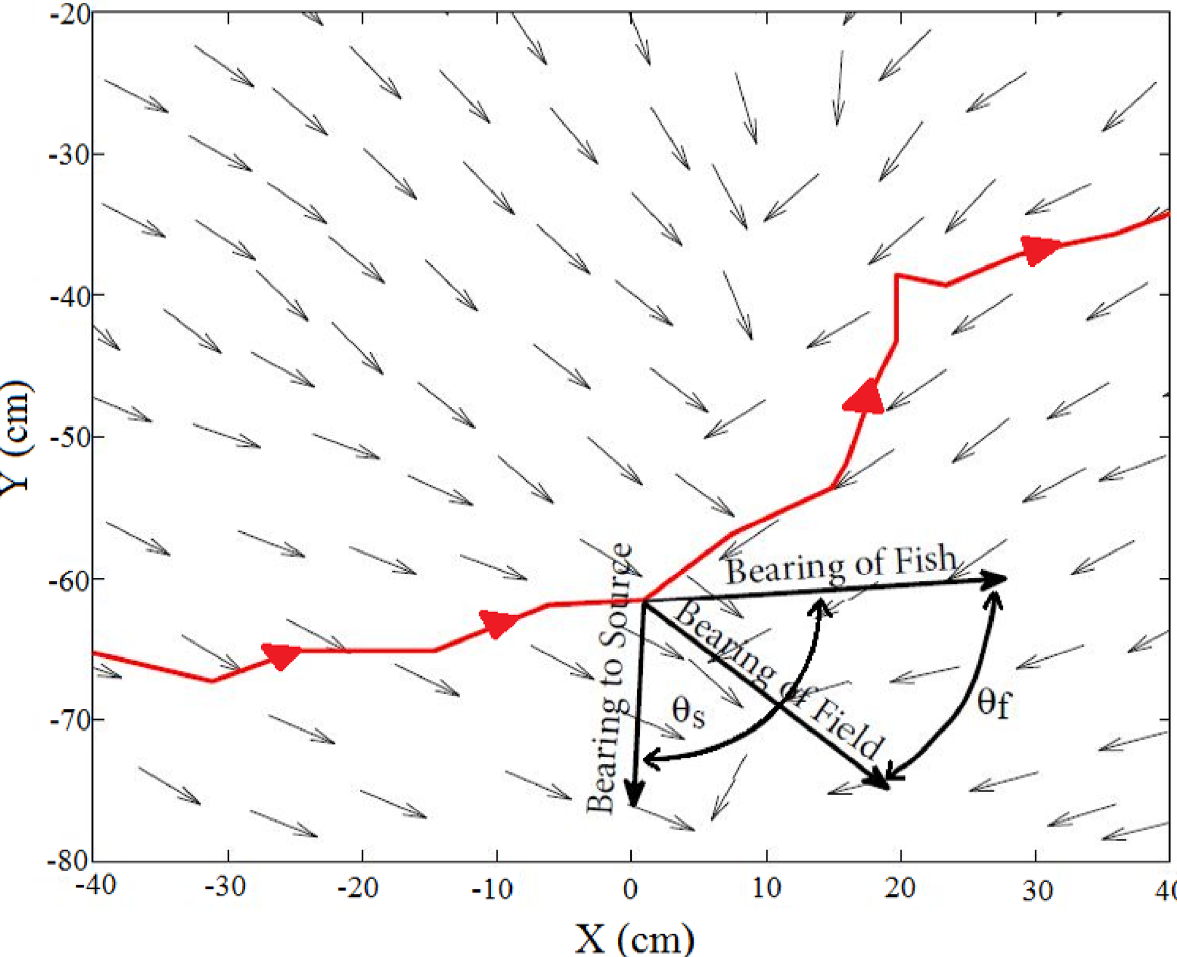
Fig 4. Difference angle of the fish’s bearing relative to the sound source (located at X = 0 cm), θ S , and the local particle acceleration vectors, θ F , at a given location along an individual swimming trajectory. Small arrows indicate local particle acceleration vectors (normalizedfor visual comparison), and the solid line indicatesa sample swimmingtrajectory. Differenceangles were calculated with reference to the origin (i.e. both difference anglesin the examplewouldhave a negativevalue).